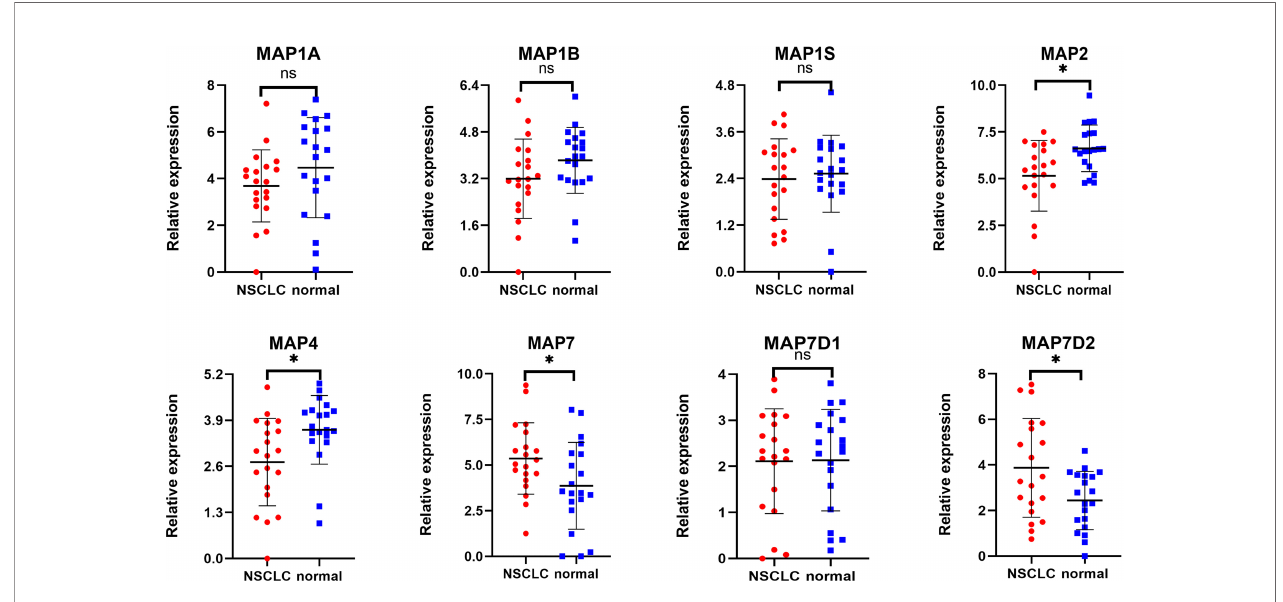
FIGURE 11 | RT-qPCR analysis of MAP expression in 20 pairs of NSCLC samples and paratumor tissues. *p < 0.05. MAP, microtubule-associated protein; NSCLC, non-small cell lung cancer; RT-qPCR, reverse transcription-quantitative polymerase chain reaction. ns, not signi fi